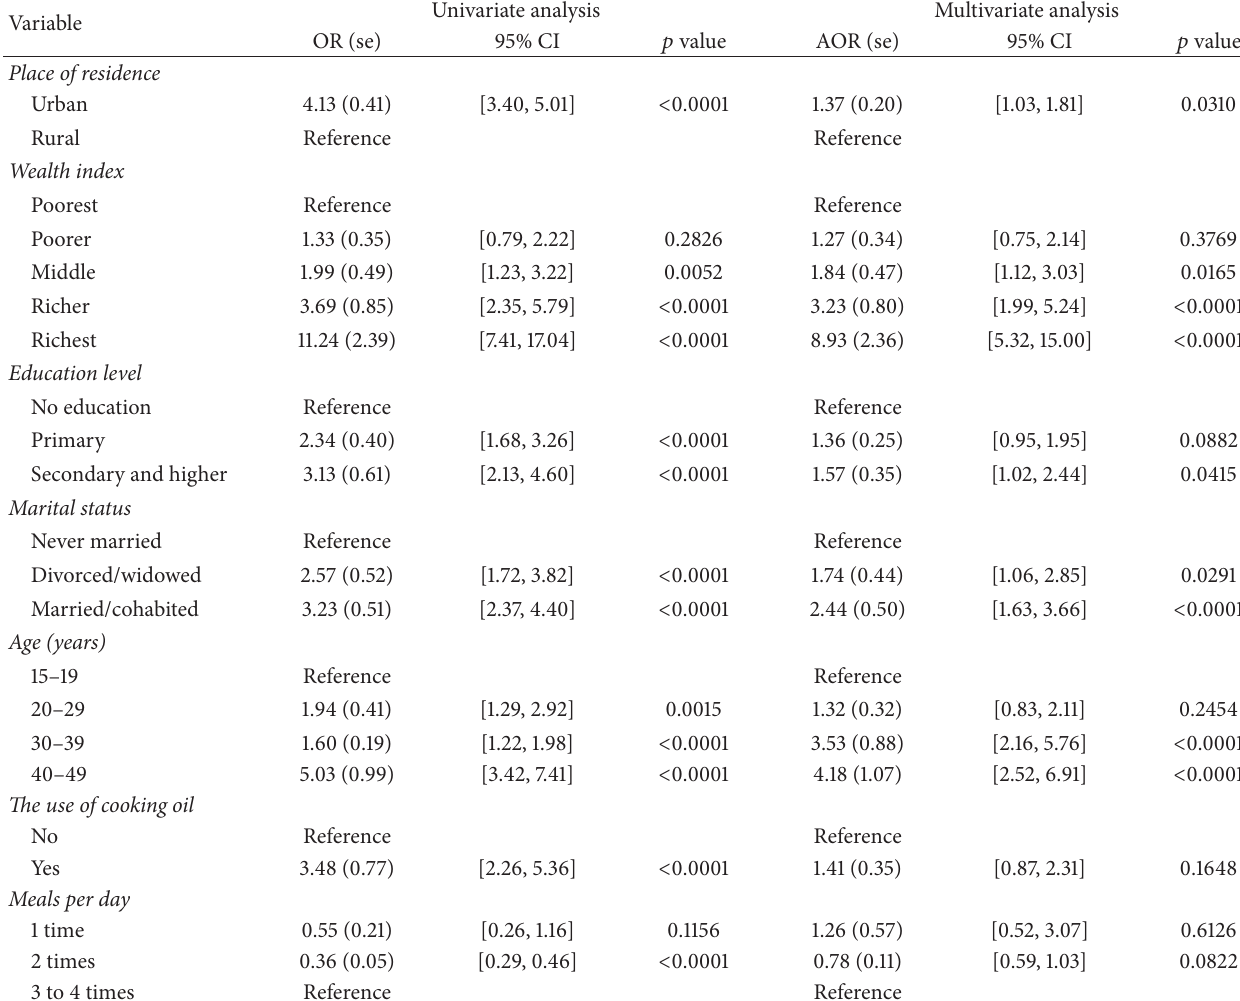
Table 3: Crude and adjusted odds ratios of obesity among nonpregnant women in Mainland